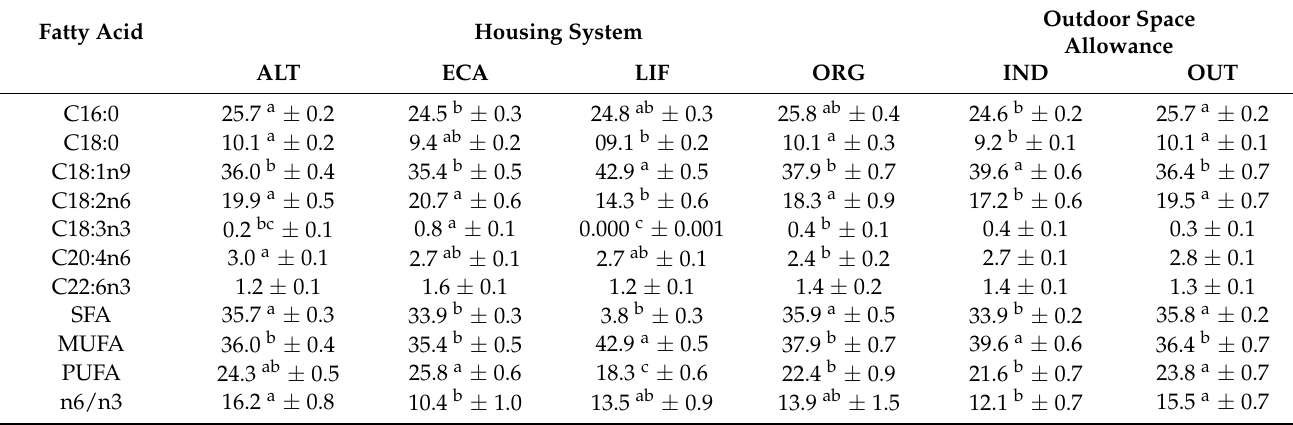
Table 3. Yolk fatty acids concentration (% of total fatty acids; LS Mean ± SE) in eggs from different housing systems and different outdoor space allowance (OSA; IND = indoor, OUT = outdoor space). (LS means ± SE). Outdoor Space Fatty Acid Housing System Allowance LIF IND